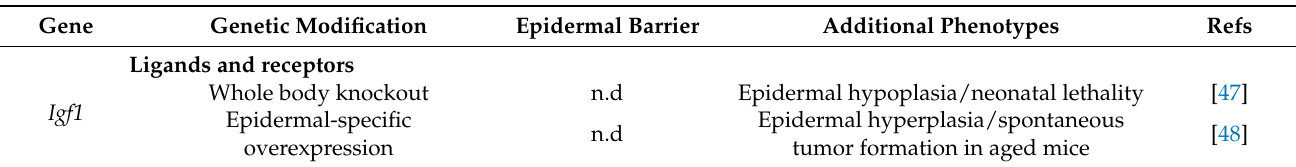
Table 1. Skin phenotypes of mouse models with modified mTOR signaling and its up- downstream